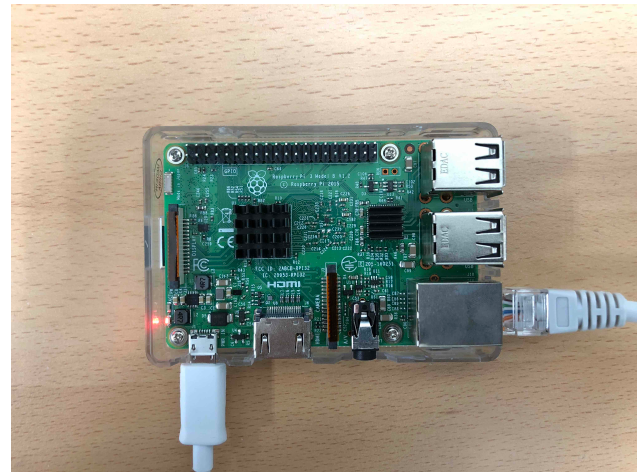
Figure 6. Raspberry Pi 3 Model B used in the